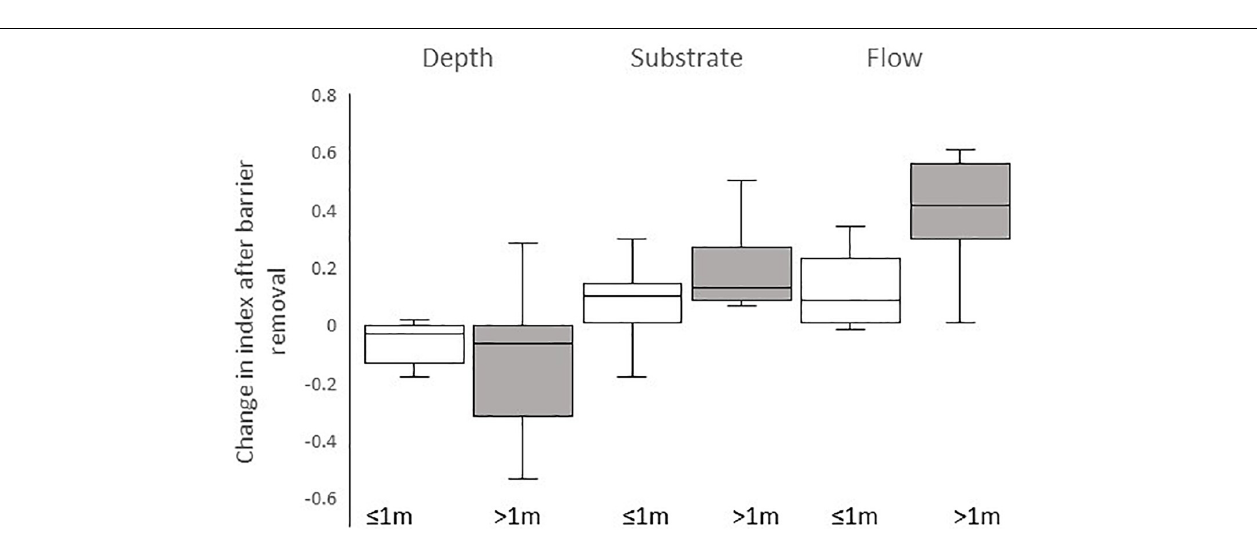
FIGURE 3 | Boxplots of change in index of depth, substrate size, and flow following barrier removal at sites with head loss of ≤ 1 m (white boxes) and head loss of > 1 m (gray boxes). The line within each box represents median change in index, ends of boxes represent the 25th and 75th percentiles, and whiskers represent the 10th and 90th